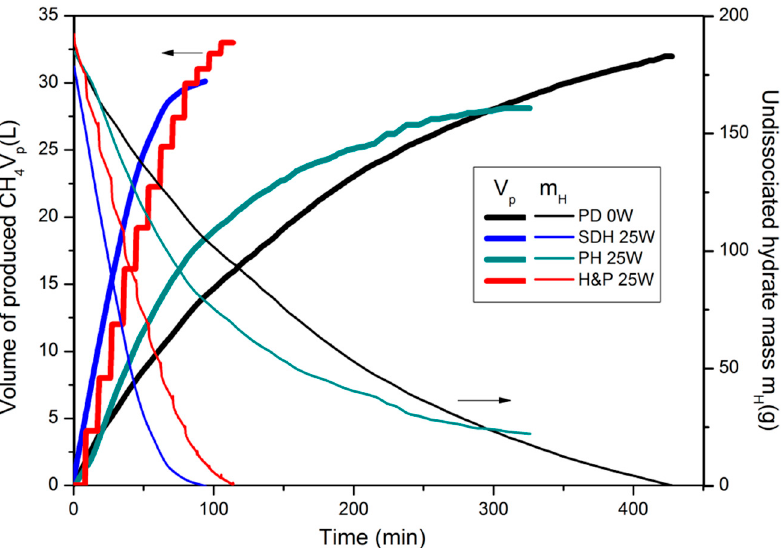
Figure 5. The volume of produced CH 4 ( V P ) and undissociated hydrate mass ( m H ) with different exploitation methods.